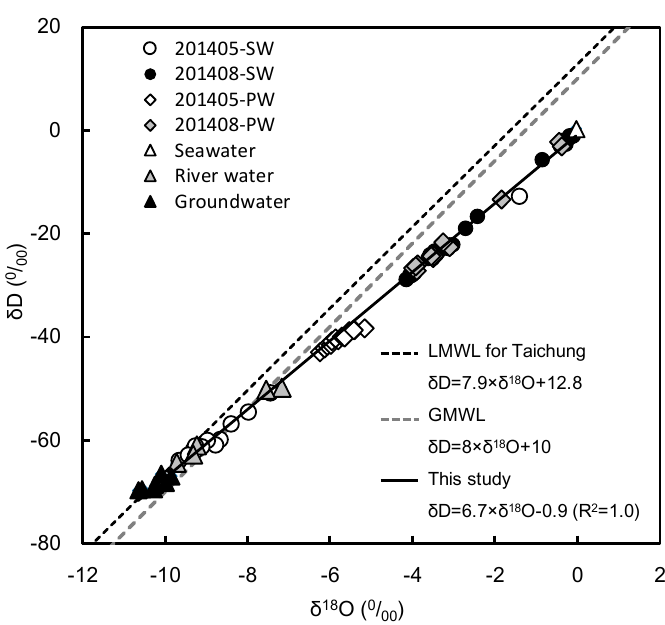
Figure 4. The plot of δ D vs. δ 18 O for all water samples collected from the Gaomei Wetland, including SW (surface coastal water), PW (pore water form 35 cm below the seabed), groundwater, river water (water samples from the outlet of Da-Chia River and Qingshui drainage), and offshore seawater. The solid line shows its linear regression line ( δ D = 6.7 × δ 18 O − 0.9; R 2 = 1.0); while the black dotted line is the Local Meteoric Water Line (LMWL; δ D = 7.9 × δ 18 O + 12.8; [52]) for the Taichung groundwater catchment and the gray line is the Global Meteoric Water Line (GMWL; δ D = 8 × δ 18 O + 10; [53]).